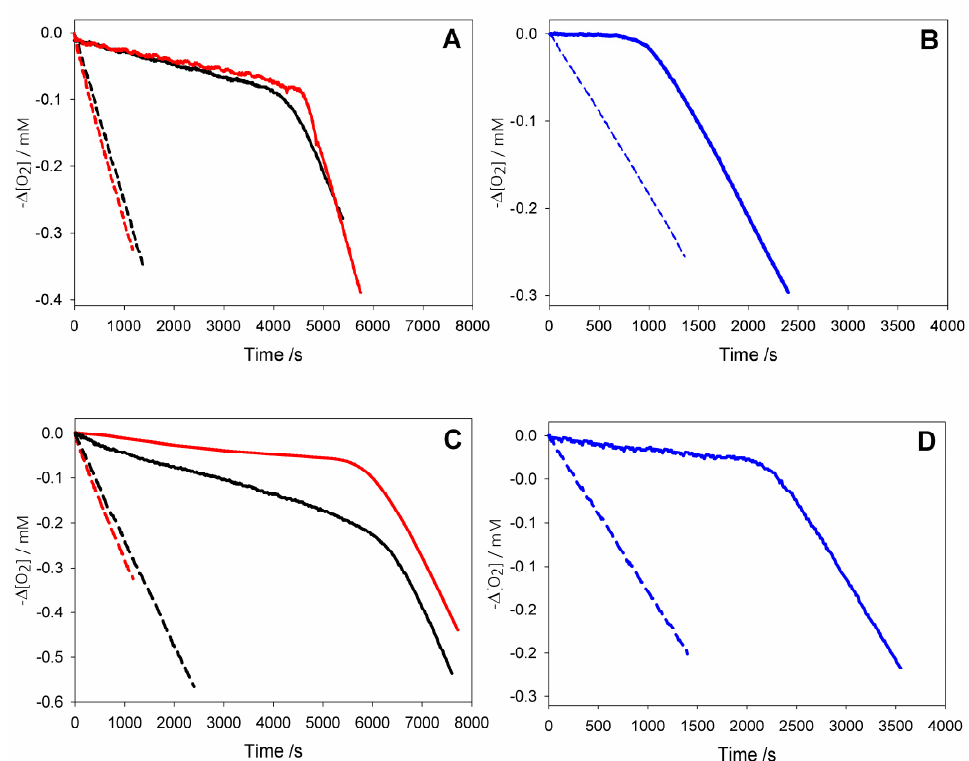
Figure 4. Oxygen consumption during the autoxidation of: (black) cumene (1.8 M) initiated by AIBN (0.05 M) at 30 ◦ C in dry acetonitrile, or (red) with addition of 1% wt water ( A , C ), and (blue) during the autoxidation of THF (3.1 M) initiated by AAPH (25 mM) in phosphate buffer (0.1 M pH = 7.4) at 30 ◦ C ( B , D ) without inhibitors (dash line); or in the presence of AH 2 2.5 × 10 − 5 M (solid line, A ); or of AH 2 2.2 × 10 − 5 M (solid line, B ); or in the presence of HNT/AH 2 0.18 mg/mL (corresponding to AH 2 2.5 × 10 − 5 M, solid line, C ); or in the presence of HNT/AH 2 0.16 mg/mL (corresponding to AH 2 2.2 × 10 − 5 M, solid line, D ).